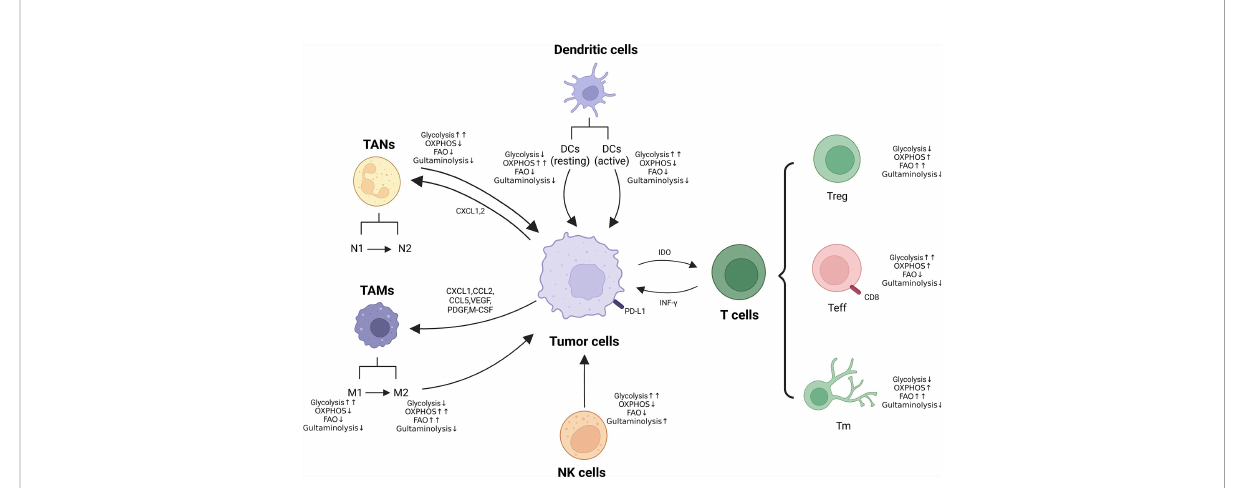
FIGURE 3 Metabolic reprogramming of immune cells in TME. Metabolic alterations of macrophages, neutrophils, NK cells and T cells (Treg, Teff and Tm) are presented. ↑↑ : Signi fi cantly up-regulated; ↑ : Up-regulated; ↓ :